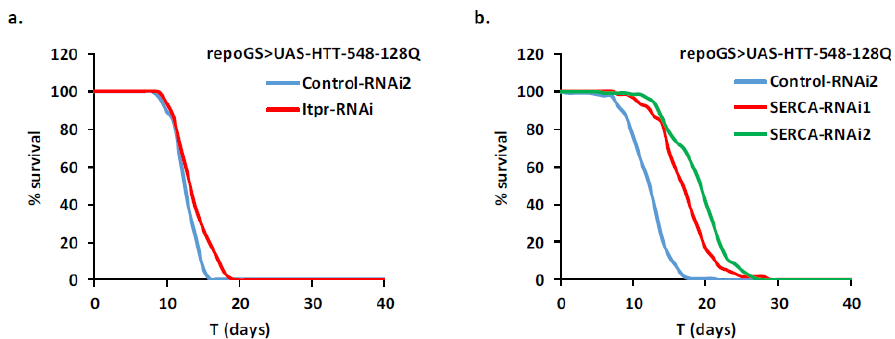
Figure 4. Repression of SERCA is protective in HD glia. A repoGS > UAS-HTT-548-128Q line was crossed with transgenic lines modulating Itpr (Itpr-RNAi) or SERCA (SERCA-RNAi1 and SERCA- RNAi2) (see Table S4 for detailed genotypes) and the lifespan of the progeny after induction with RU100 was compared. ( a ) Adult glia depletion of Itpr did not change the median lifespan of the mHTT expressing flies but marginally increased their mean lifespan (MLS = 13.1 vs. 12.0 for controls; n = 99, 150, respectively; pLogRank < 10 −4 ). ( b ) Adult glia depletion of SERCA strongly increased the mean lifespan of the mHTT expressing flies (MLS = 16.4, 18.3; n = 59, 150; pLogRank < 10 −10 , respectively). Control-RNAi2 flies: MLS = 11.5, n = 141.